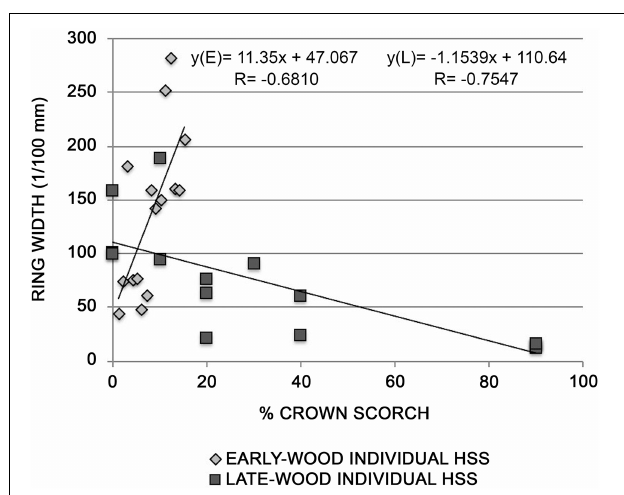
FIGURE 4 | Relationship between tree-ring widths of early-wood (E) and late-wood (L) of HSS site and the % of scorched